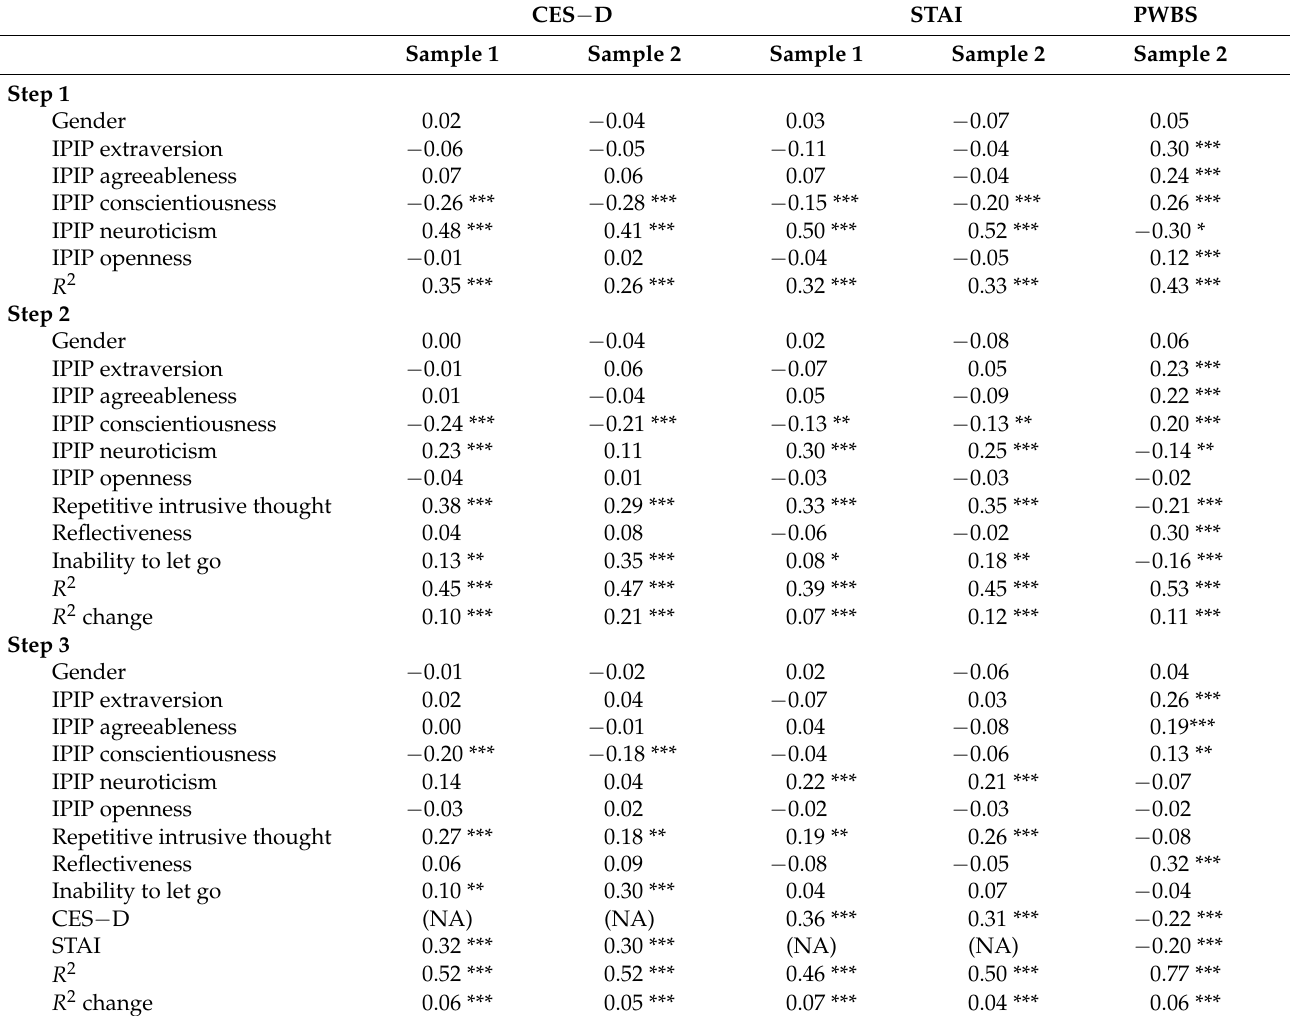
Table 4. Results from multiple regression analyses predicting dysphoria (CES-D), anxiety (STAI), and psychological well-being (PWBS) from gender, the Big Five, repetitive intrusive thought, re- flectiveness, inability to let go, and mood. All regression coefficients are beta coefficients (i.e., standardized